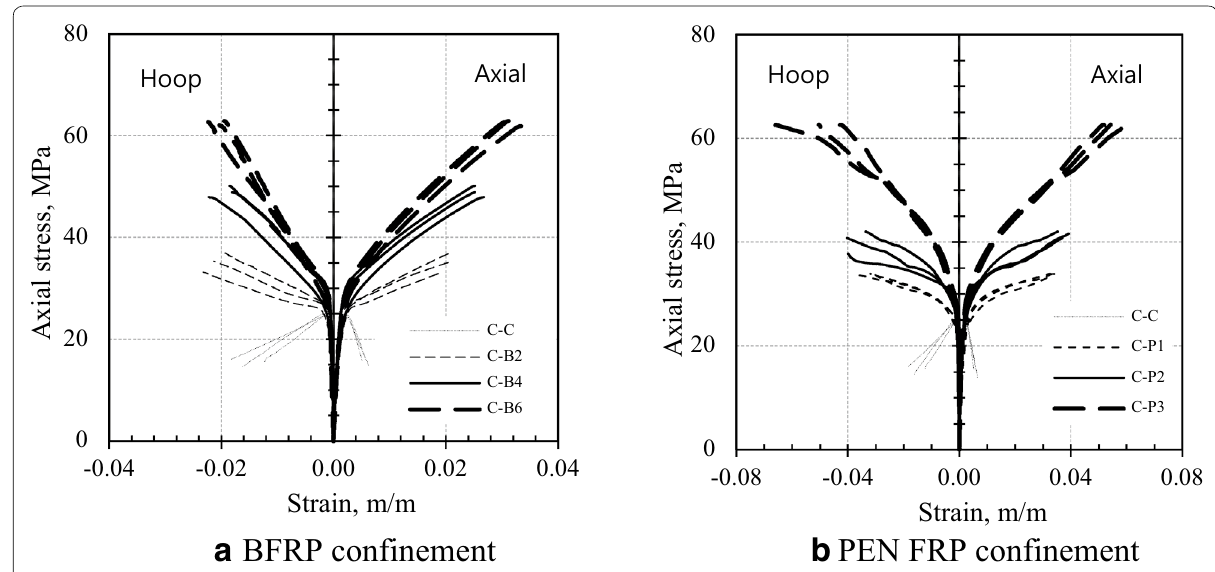
Fig. 6 Axial stress-axial/hoop strain plot of BFRP and PEN FRP confined